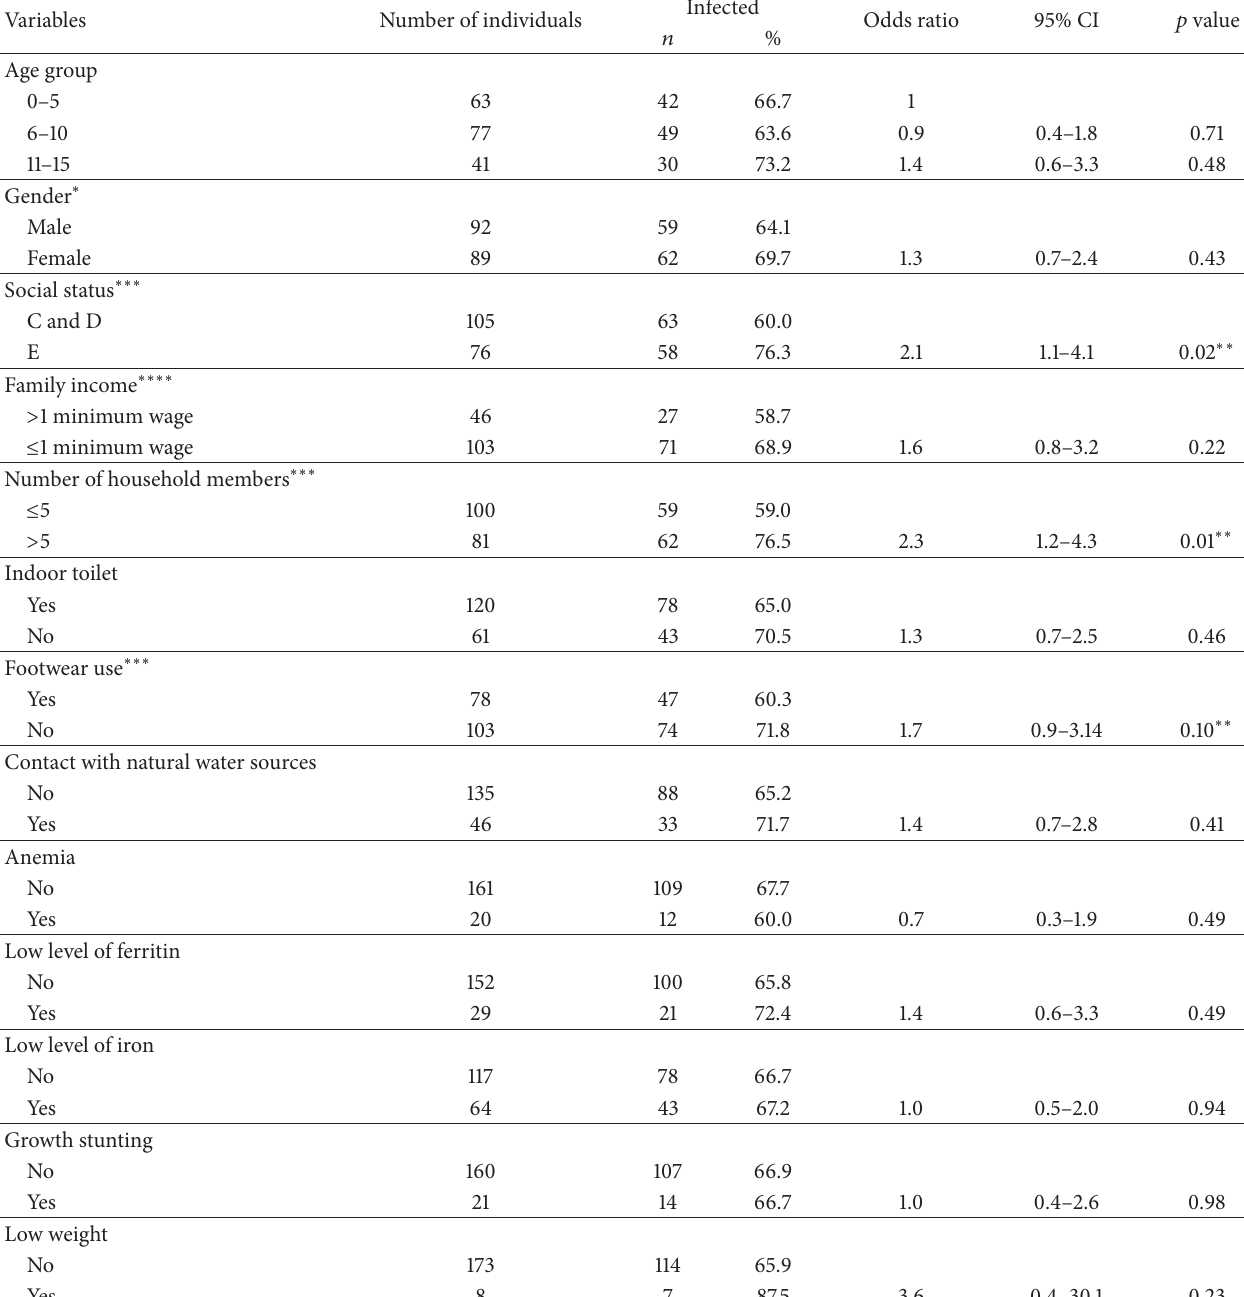
Table 3: Bivariate analysis for factors potentially associated with intestinal parasitic infection among children aged 0 to 15 years, from a substandard settlement in Macei´o, Alagoas,